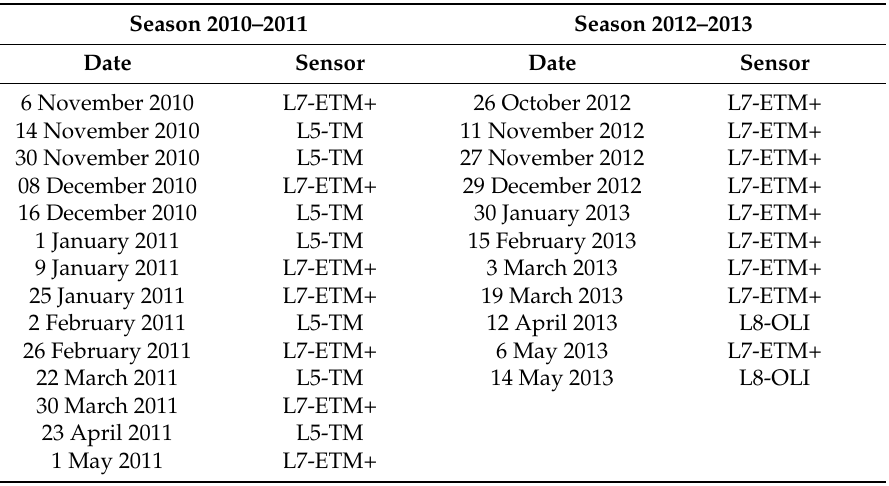
Table 2. Sensor and image acquisition date for the apple